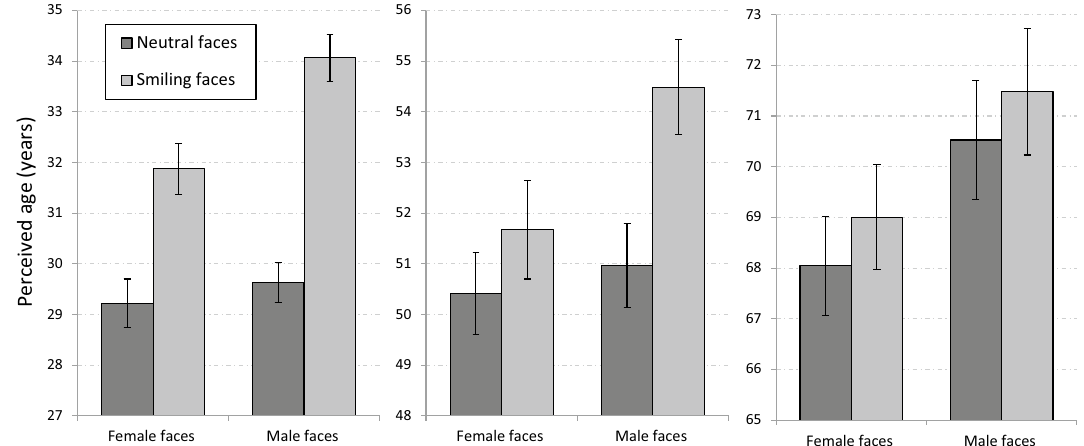
Figure 3. The AES for the eye region of faces in different age groups (Experiment 1b). Smiling faces were perceived as older than neutral faces for both genders and in all age groups. Error bars represent standard errors of the